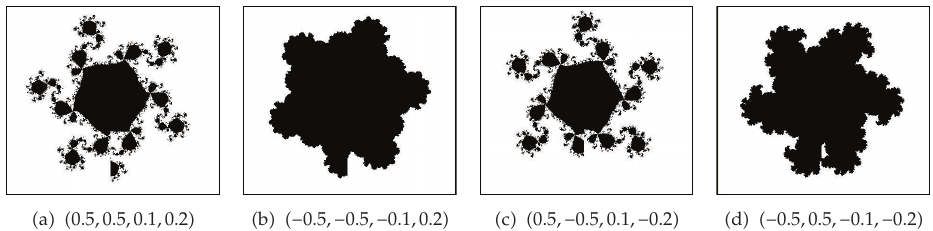
Figure 11: The generalized J sets perturbed by additive noise with di ff erent parameters (cid:3) a,b,m 1 ,m 2 (cid:4) when α (cid:6) 5 . 5, θ ∈ (cid:7) − 3 π/ 2 ,π/ 2 (cid:4)